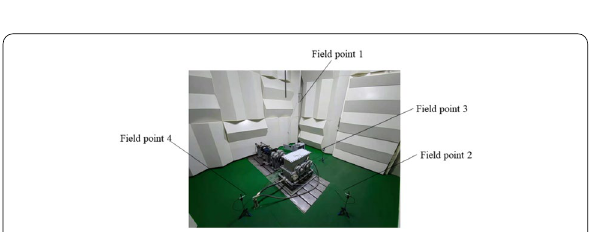
Figure 16 Sound field points layout of noise